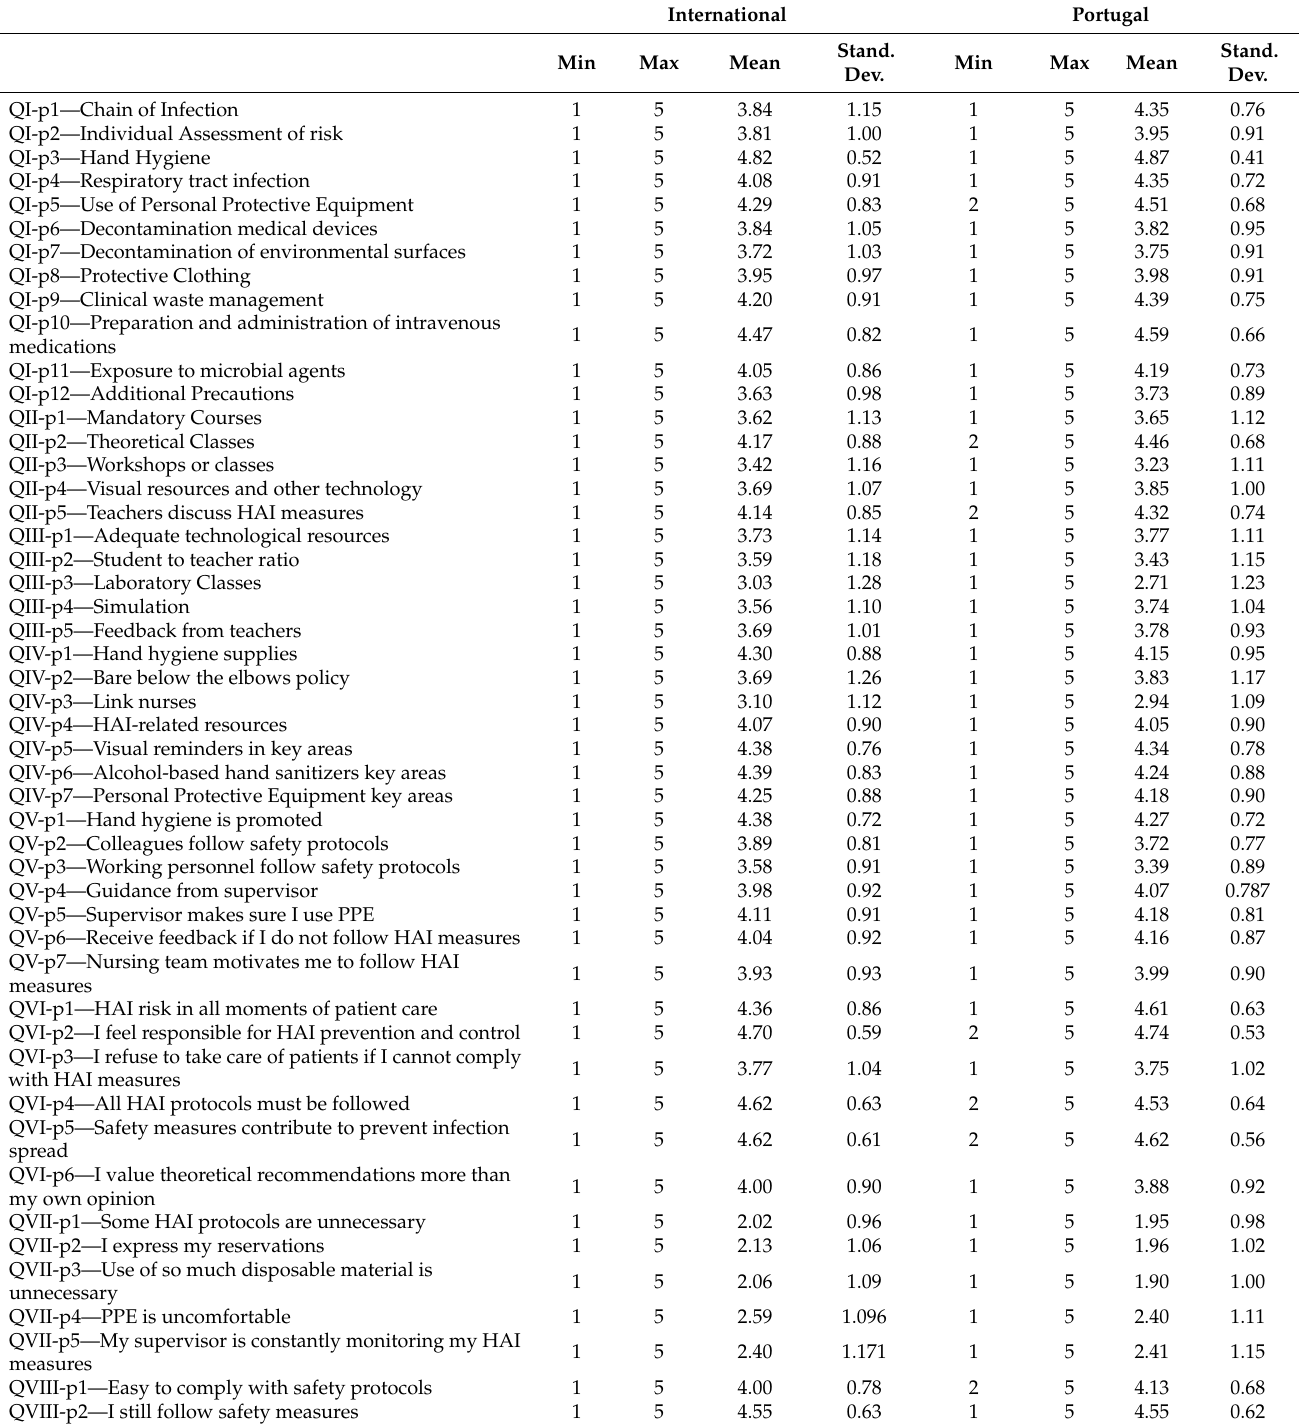
Table 2. Student’s perception about good practice in HAI from Portugal and International sample (including Poland Spain, and Finland). International Portugal Stand. Stand. Min Max Mean Max Dev.